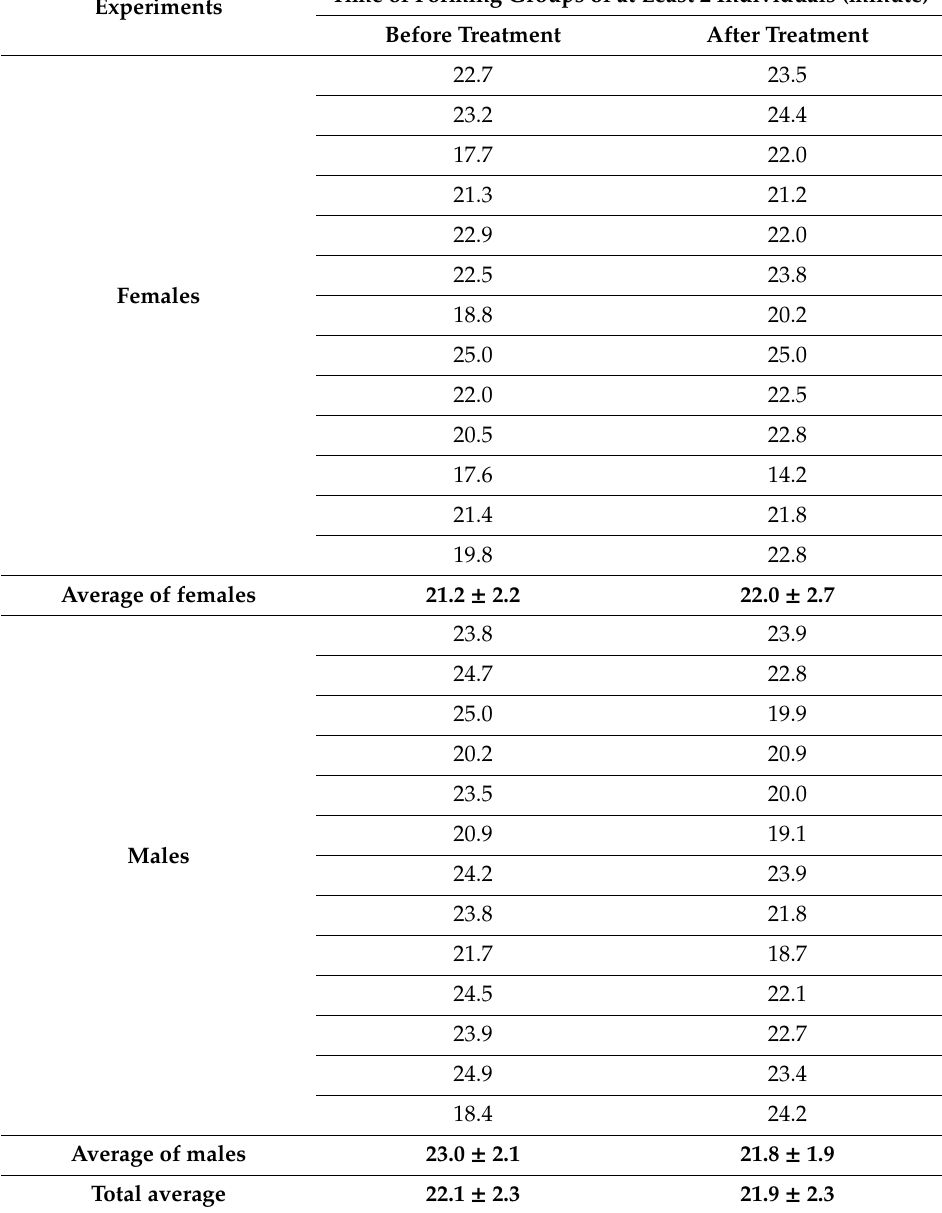
Table 1. Time any individual spent in groups of at least two individuals (including the target one) before and after the application of linseed oil. Males and females were tested in separate experiments. Total observation time = 25 min, Group size = 6 individuals, N =